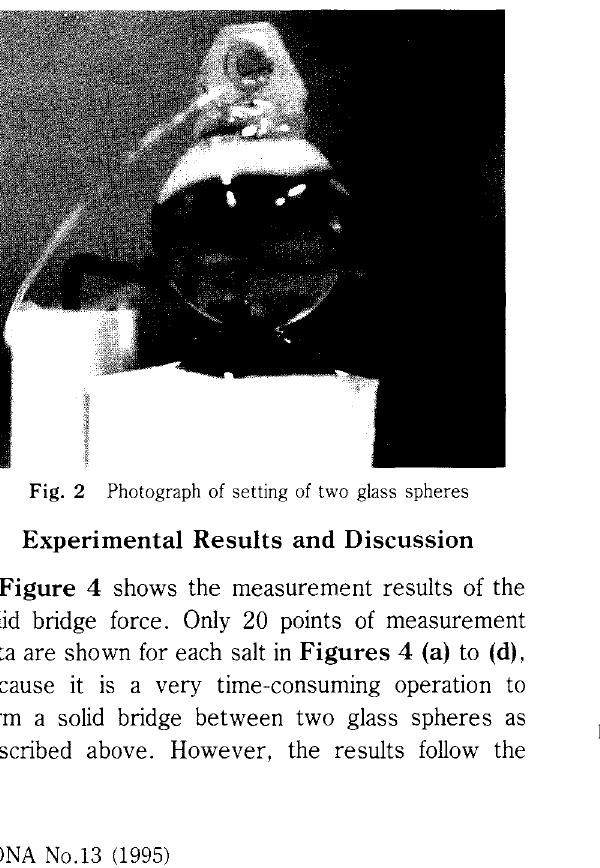
Fig. 3 Experimental set up